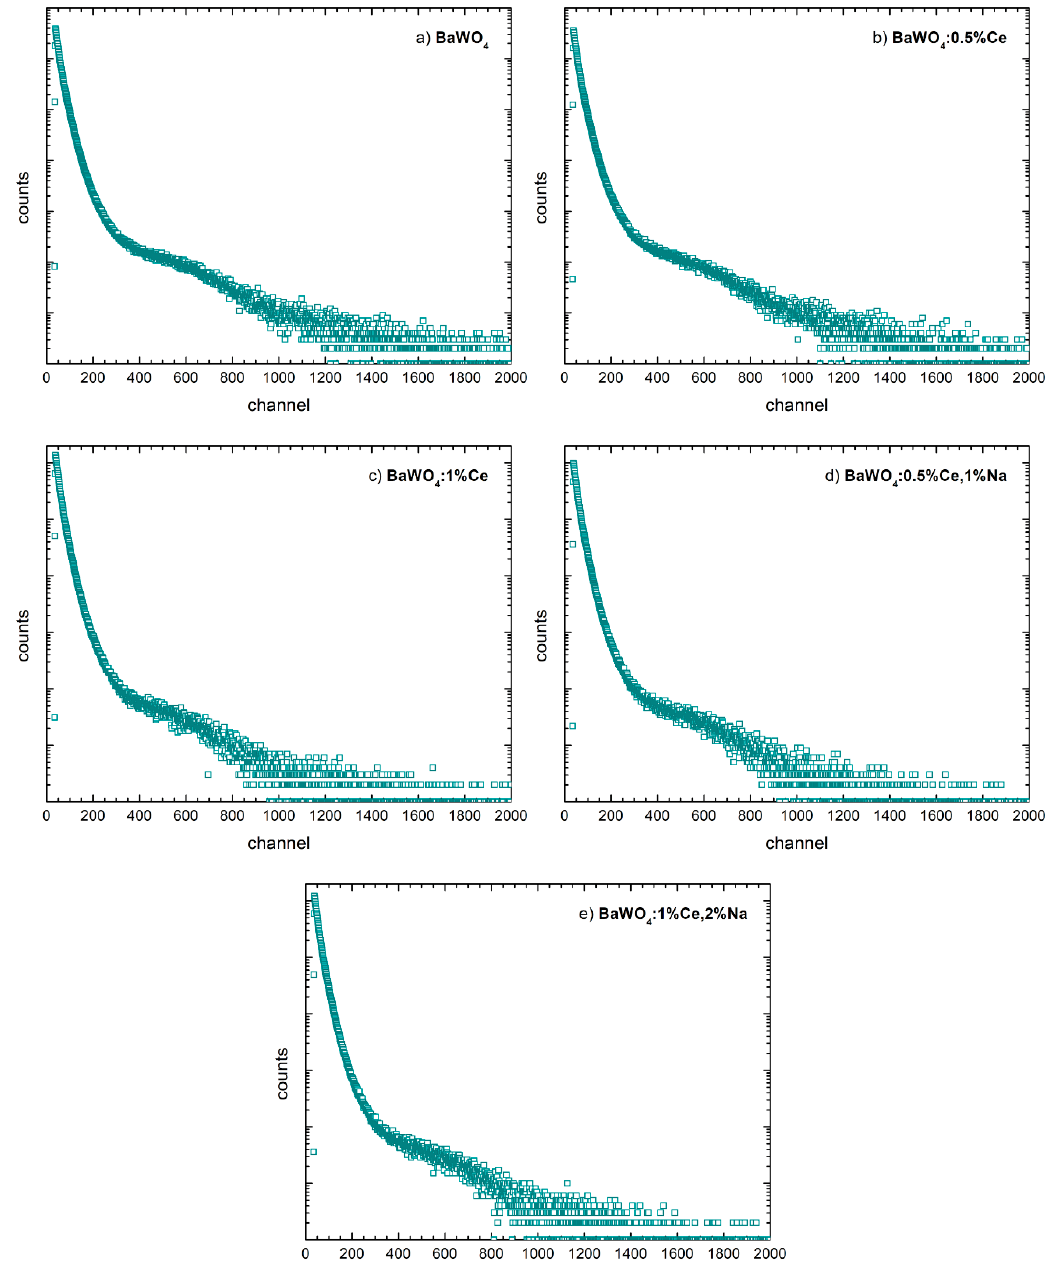
Figure 10. Pulse height spectra of the investigated samples: ( a ) BaWO 4 ; ( b ) BaWO 4 : 0.5% Ce; ( c ) BaWO 4 : 1% Ce; ( d ) BaWO 4 : 0.5% Ce, 1% Na; ( e ) BaWO 4 : 1% Ce, 2% Na.